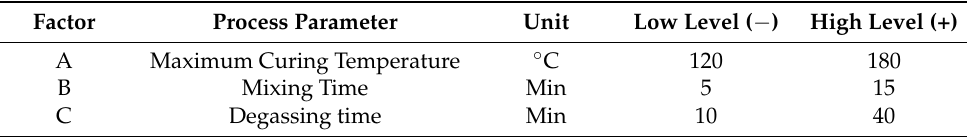
Table 4. Factors and levels of variable